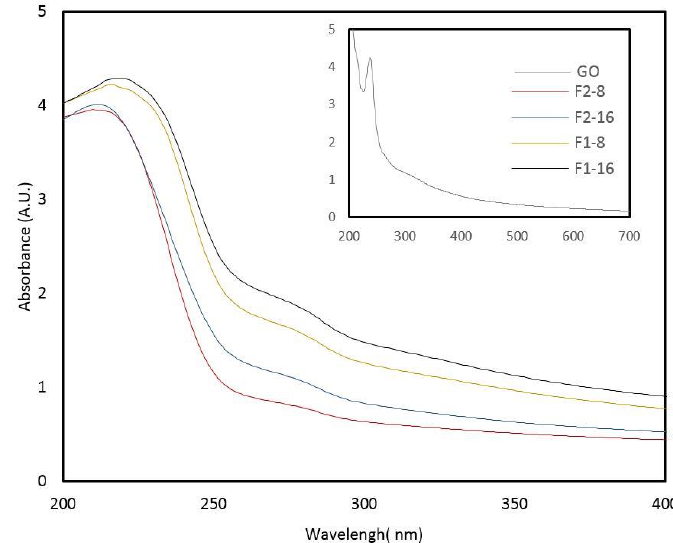
Figure 3. UV-Vis spectra of composite films from GO-ASC-g-P(MMA-co-EA) suggesting π–π stacking of the components with increasing GO contents.